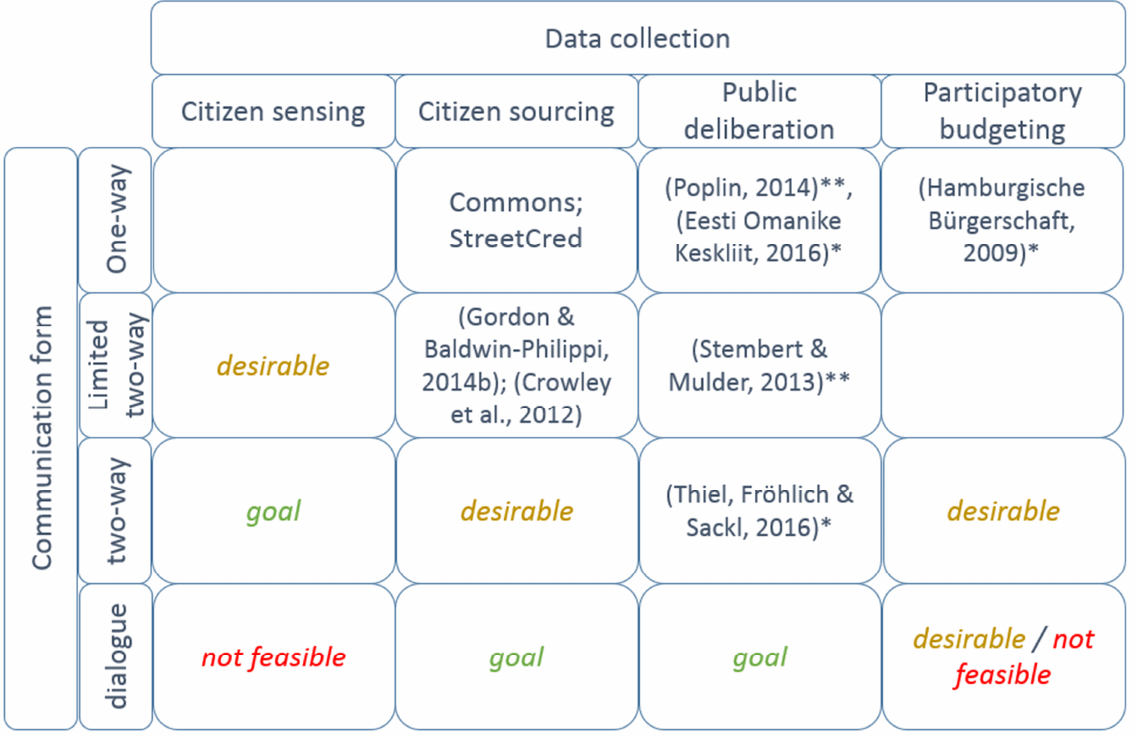
Figure 1: Matrix of e-Participation Platforms Applying Gamification 1